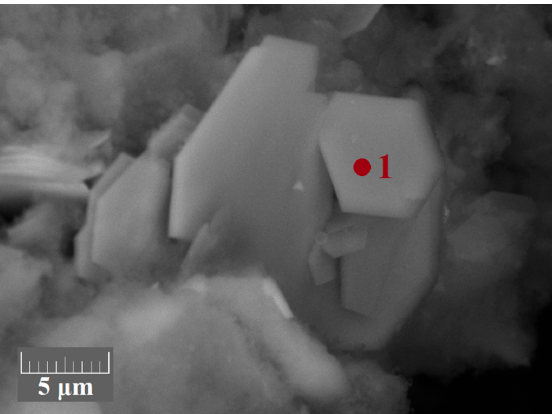
Figure 8. SEM image of an area in the solid residue obtained by leaching of the WAT sample using 10% HCl at 150 °C and S:L ratio = 1:11 for 60 min. The composition of the point 1 is given in Table 2.